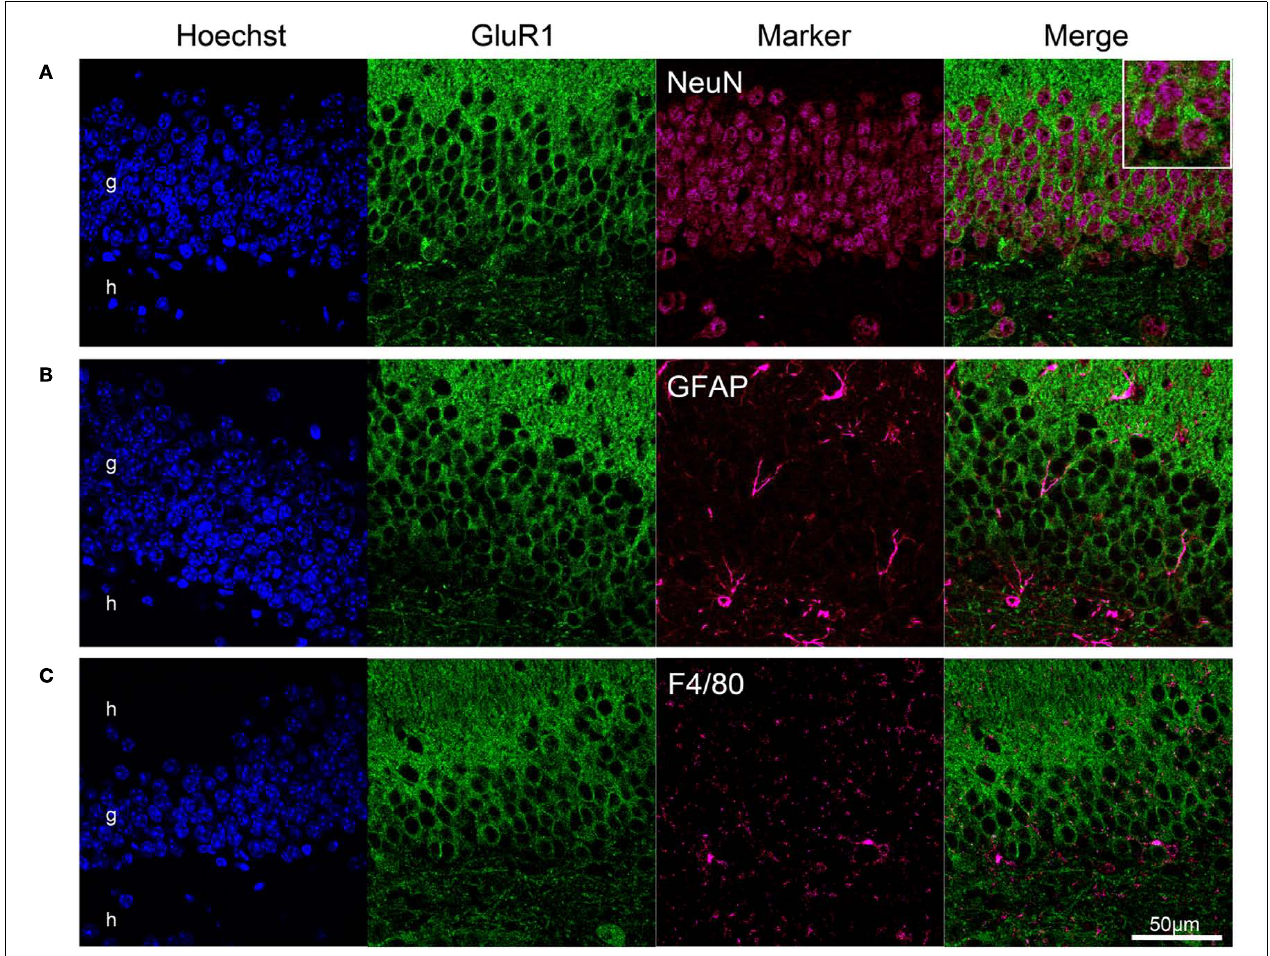
FIGURE 2 | GluR1 expression in neurons but not in glial cells. Neuronal expression of GluR1 in the dentate gyrus. Immunofluorescence analysis revealed GluR1 expression in neurons labeled with the NeuN antibody (A) ,